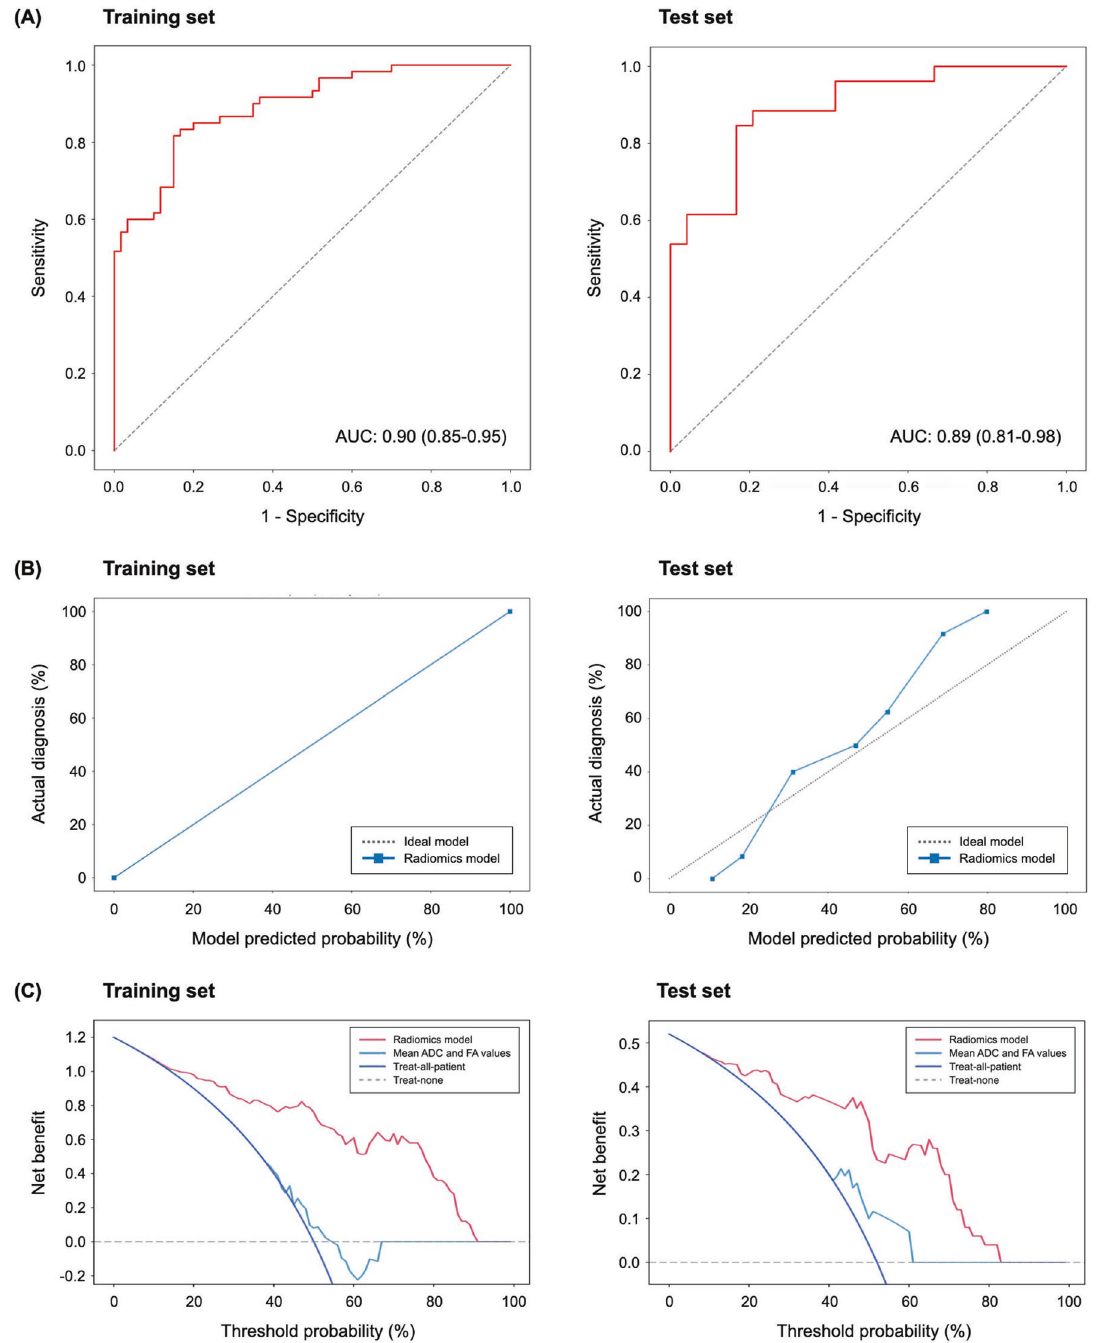
Fig. 2 Discrimination, calibration, and clinical utility of the radiomics model for the diagnosis of schizophrenia in the training and test sets. A Receiver operating characteristics curves in the training and test sets. B Calibration plots of the radiomics model in the training and test sets. The x-axis represents the model predicted risk of schizophrenia. The y-axis represents the actual diagnosed proportion of schizophrenia. The gray line represents a perfect prediction by an ideal model, and the blue line represents the performance of the radiomics model. The closer fi t between the diagonal dotted lines and solid lines shows a good prediction of schizophrenia. C Decision curves for the radiomics model in the training and test sets. The x-axis represents the threshold probability, which refers to a minimum probability of having a disease that patients require to justify treatment. The y-axis represents the net bene fi t, determined based on the difference between the expected bene fi t and harm associated with the diagnosis and treatment decision. The radiomics model shows superior net bene fi t in both the training and test sets within most of the range of threshold probability compared to either default strategies (treat-all or -none) or the model with mean ADC and FAs. AUC area under the curve, ADC apparent diffusion coef fi cient, FA fractional